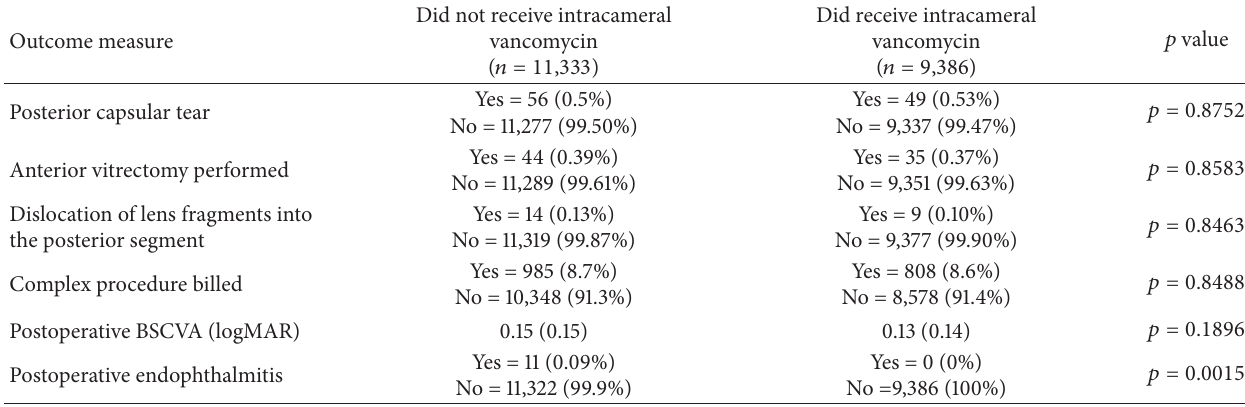
Table 2: The means and distributions with standard deviations of the intraoperative and postoperative outcomes among the group that received and the group that did not receive intracameral vancomycin during cataract